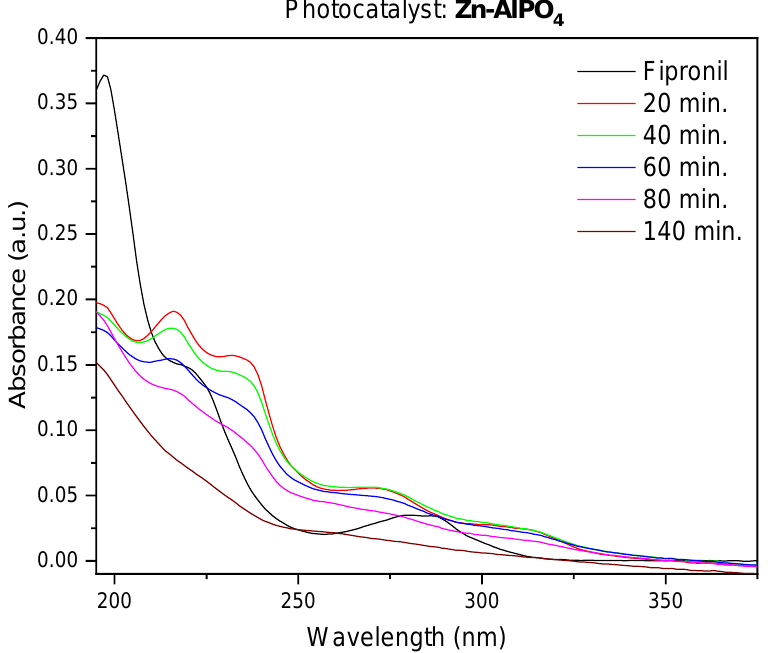
Figure 14. Absorption spectra of fipronil (Ci = 2920 µg L −1 ) in the presence of Zn-AlPO 4 (103 mg) heat-treated at 1000 °C, under mechanical stirring and UV radiation.